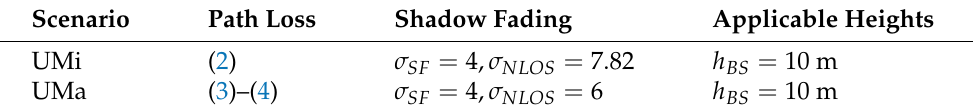
Table 3. Deployment scenarios.